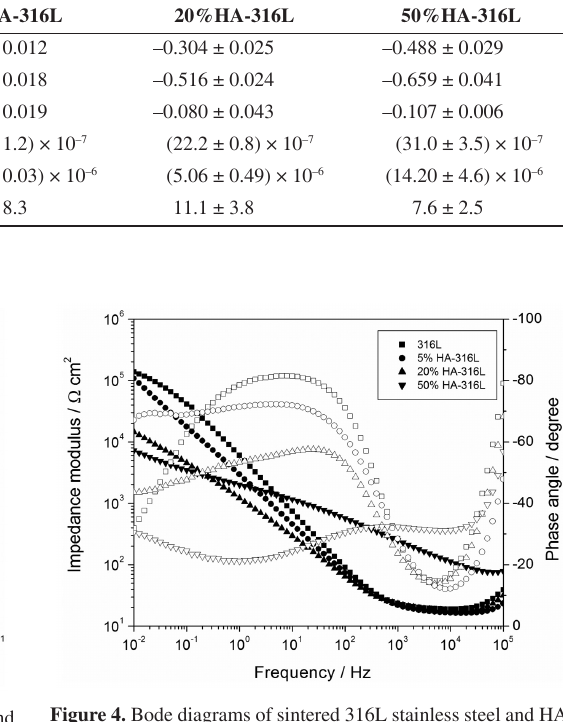
Figure 3. Polarization curves of sintered 316L stainless steel and HA‑316L composites in Ringer’s solution at room temperature.